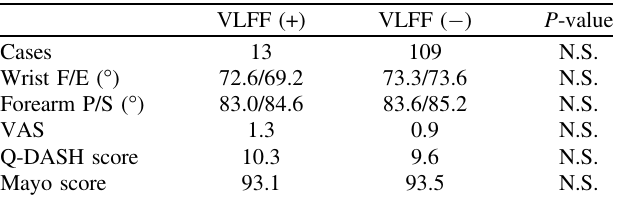
Table 1. Comparison of clinical outcomes at 12 months after surgery between VLFF (+) and VLFF ( (cid:1) )